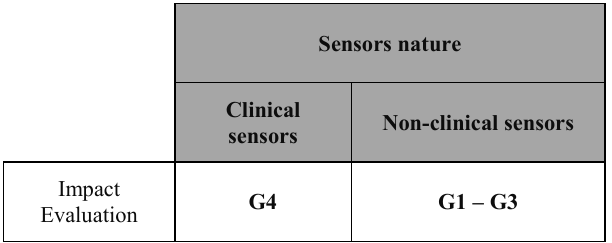
Table 3 .Impact of all the studied attacks on healthcare applications classified by nature of the sensors.